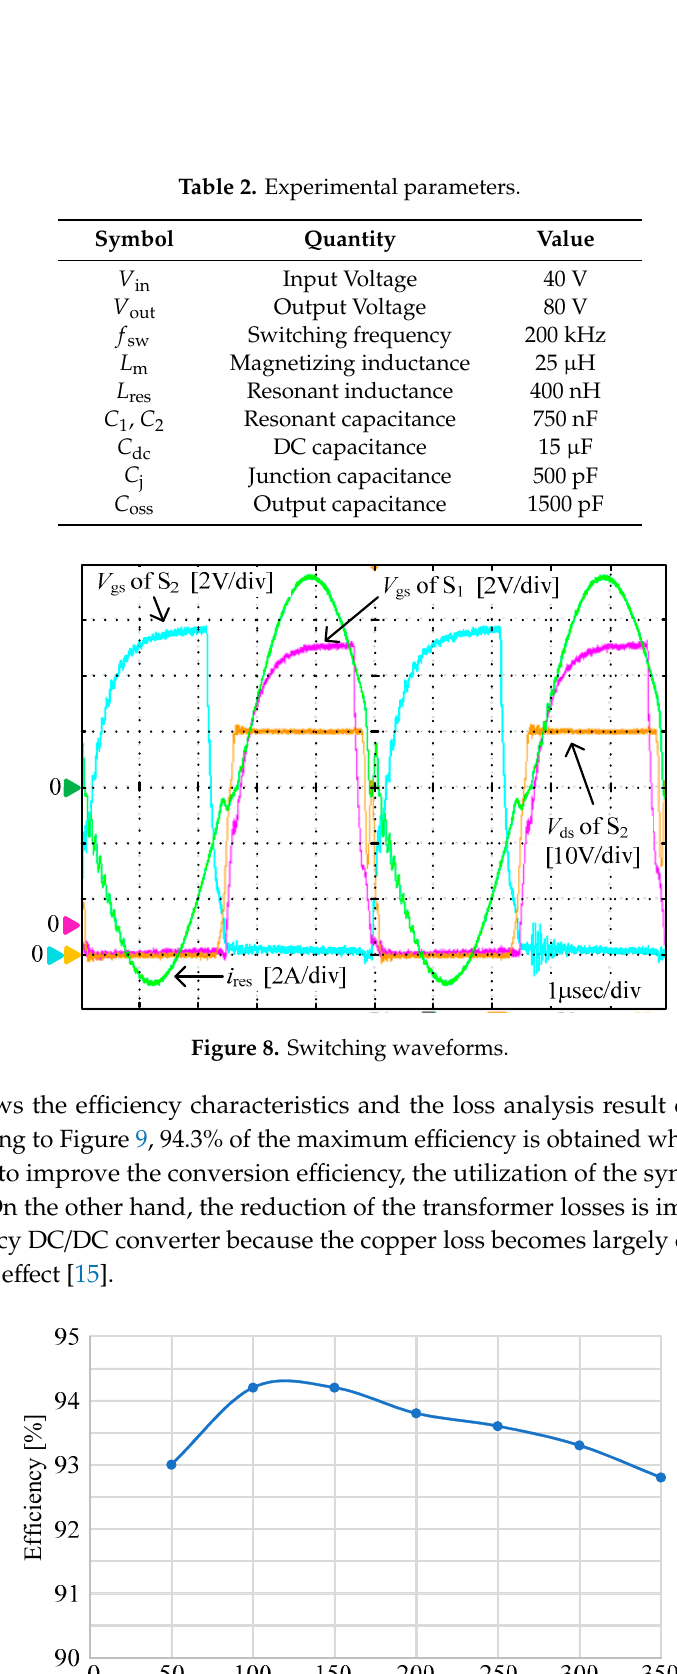
Figure 9. Efficiency curve. Figure 9. E ffi ciency